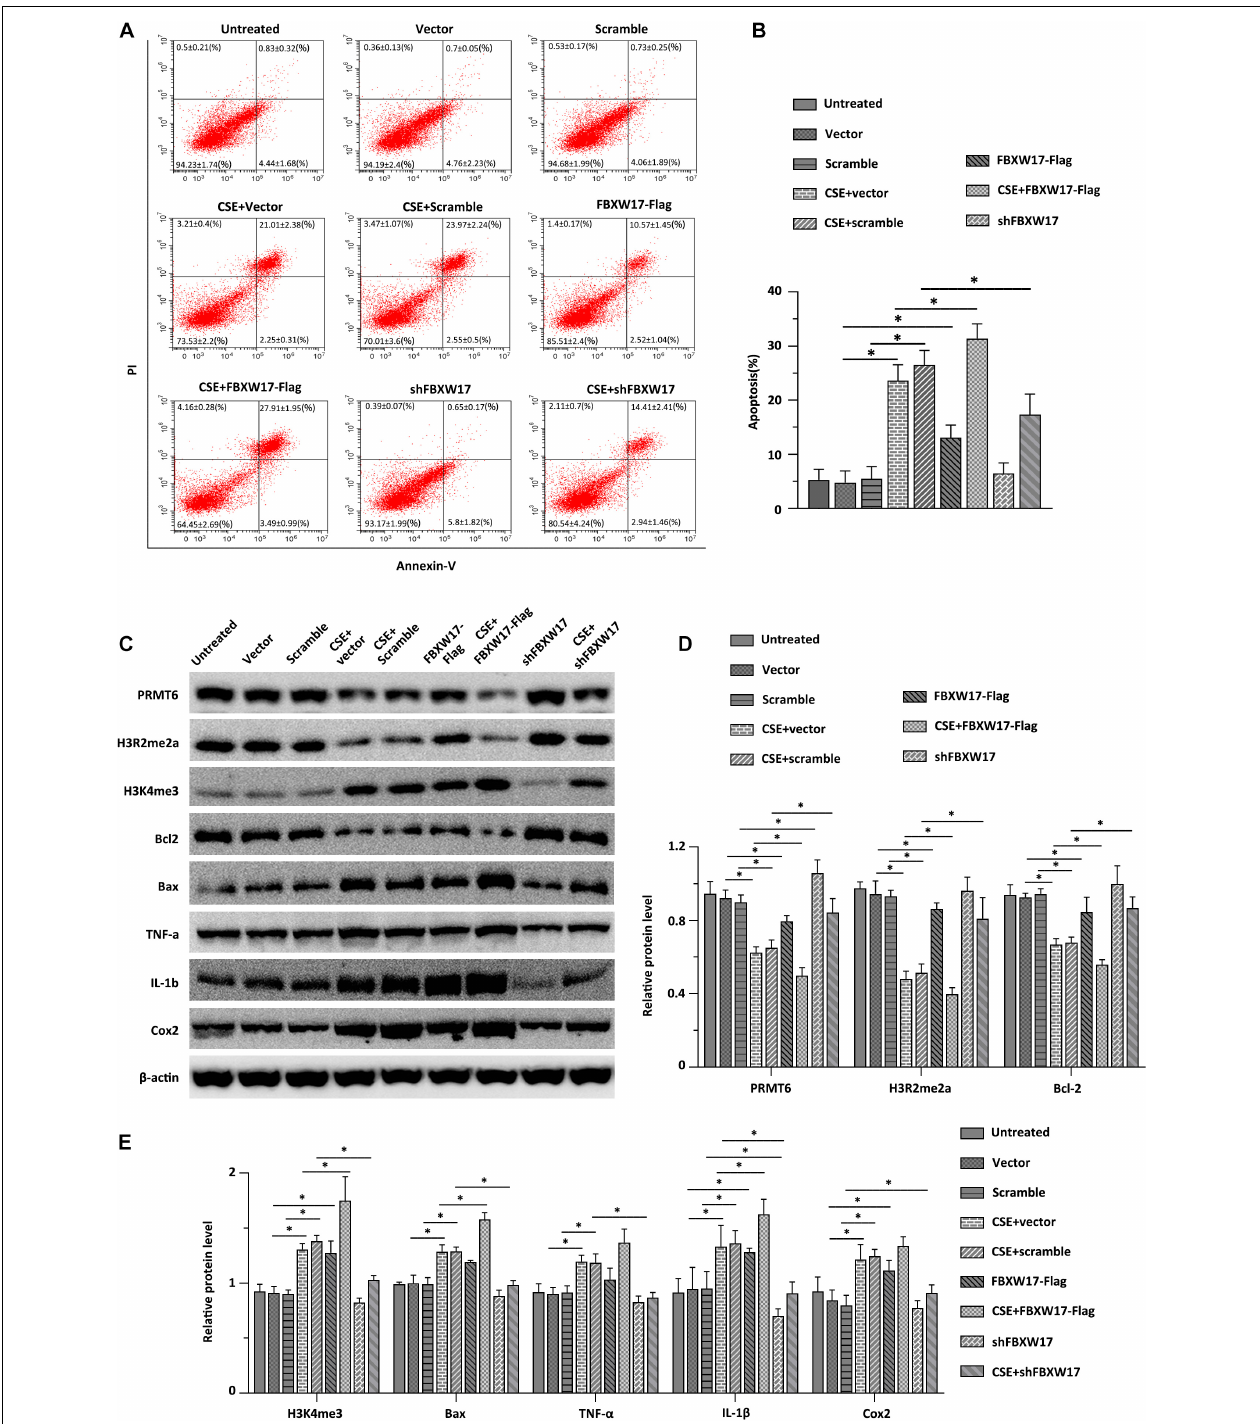
FIGURE 6 | FBXW17/protein arginine N-methyltransferase 6 (PRMT6) signaling involves in cigarette smoke extract (CSE)-induced lung epithelial inflammation and apoptosis. (A) Vector, FBXW17-FLAG plasmids, scramble small hairpin RNA (shRNA), and FBXW17 shRNA were transfected into MLE12 cells separately. Annexin V and PI kits were used to detect the rate of apoptotic cells. Before detection, cells were treated with CSE for 6 h. The “percentage of cells ± SD” values were shown in all the quadrants of flow cytometry. (B) The plotted data of apoptosis in each group are presented. (C) MLE12 cells were transfected with either overexpressed or knockdown plasmids of FBXW17. Before collection, the cells were treated with 5% CSE for 6 h. Cell lysate was conducted with immunoblotting with indicated antibodies. (D) The plotted PRMT6, H3R2me2a, and Bcl-2 protein expression were shown. (E) The relative protein expression of H3K4me3, Bax, TNF- α , IL-1 β , and COX-2 were presented. Data were represented by n = 3 separate experiments. The graph shows mean ± SD. “ ∗ ” denotes p < 0.05 between indicated groups.